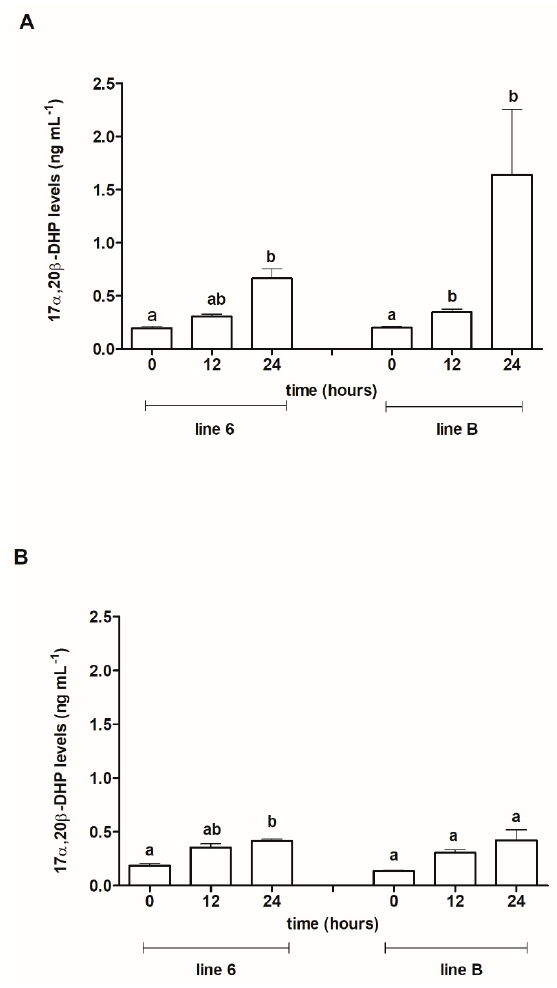
Figure 6. Plasma 17 α ,20 β -DHP levels in blood samples taken from ovulated females from Polish line 6 and Lithuanian line B ( A ) and non-ovulated females from these lines ( B ) before the first injection of Ovopel (0 h) and 12 and 24 h post-injection (12 and 24 h). Different letters used with ovulated females from both lines and non-ovulated females from line 6 denote statistically significant differences between sampling times ( p ≤ 0.05). Levels in non-ovulated fish from line B designated by the same letter do not differ significantly from each other ( p ≤ 0.05).